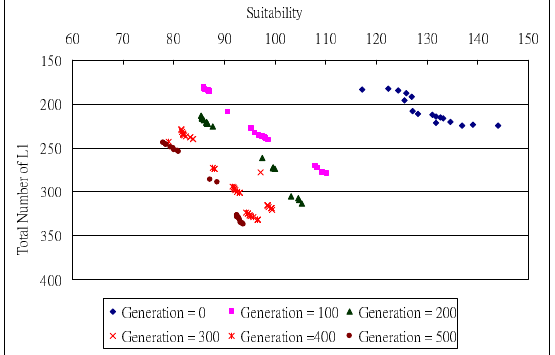
Fig. 6. The Pareto fronts derived by the proposed approach for the uniform dataset with different generations From Fig. 5 and 6, we can observe that the solutions derived from the two datasets were distributed on the Pareto fronts and the final solutions after 500 generations were better than those in different generations. Additionally, we can also found that